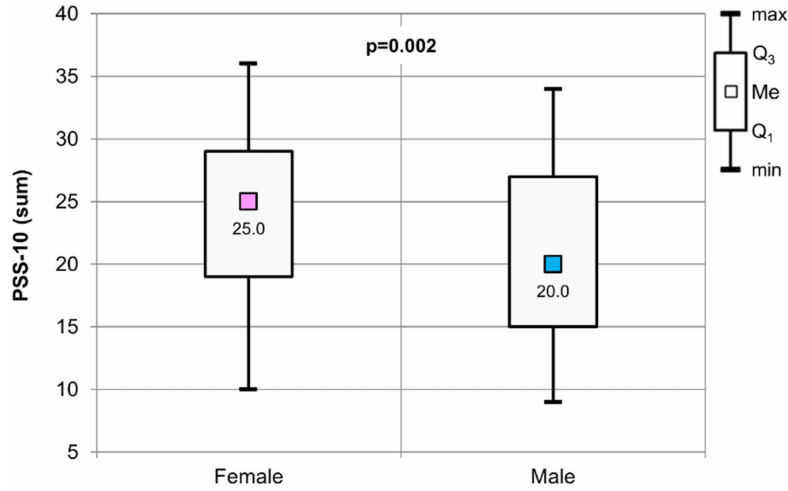
Figure 1. The results of the Mann–Whitney test used to assess the significance of difference values for the PSS-10 (sum) scale in relation to the gender of the respondents.